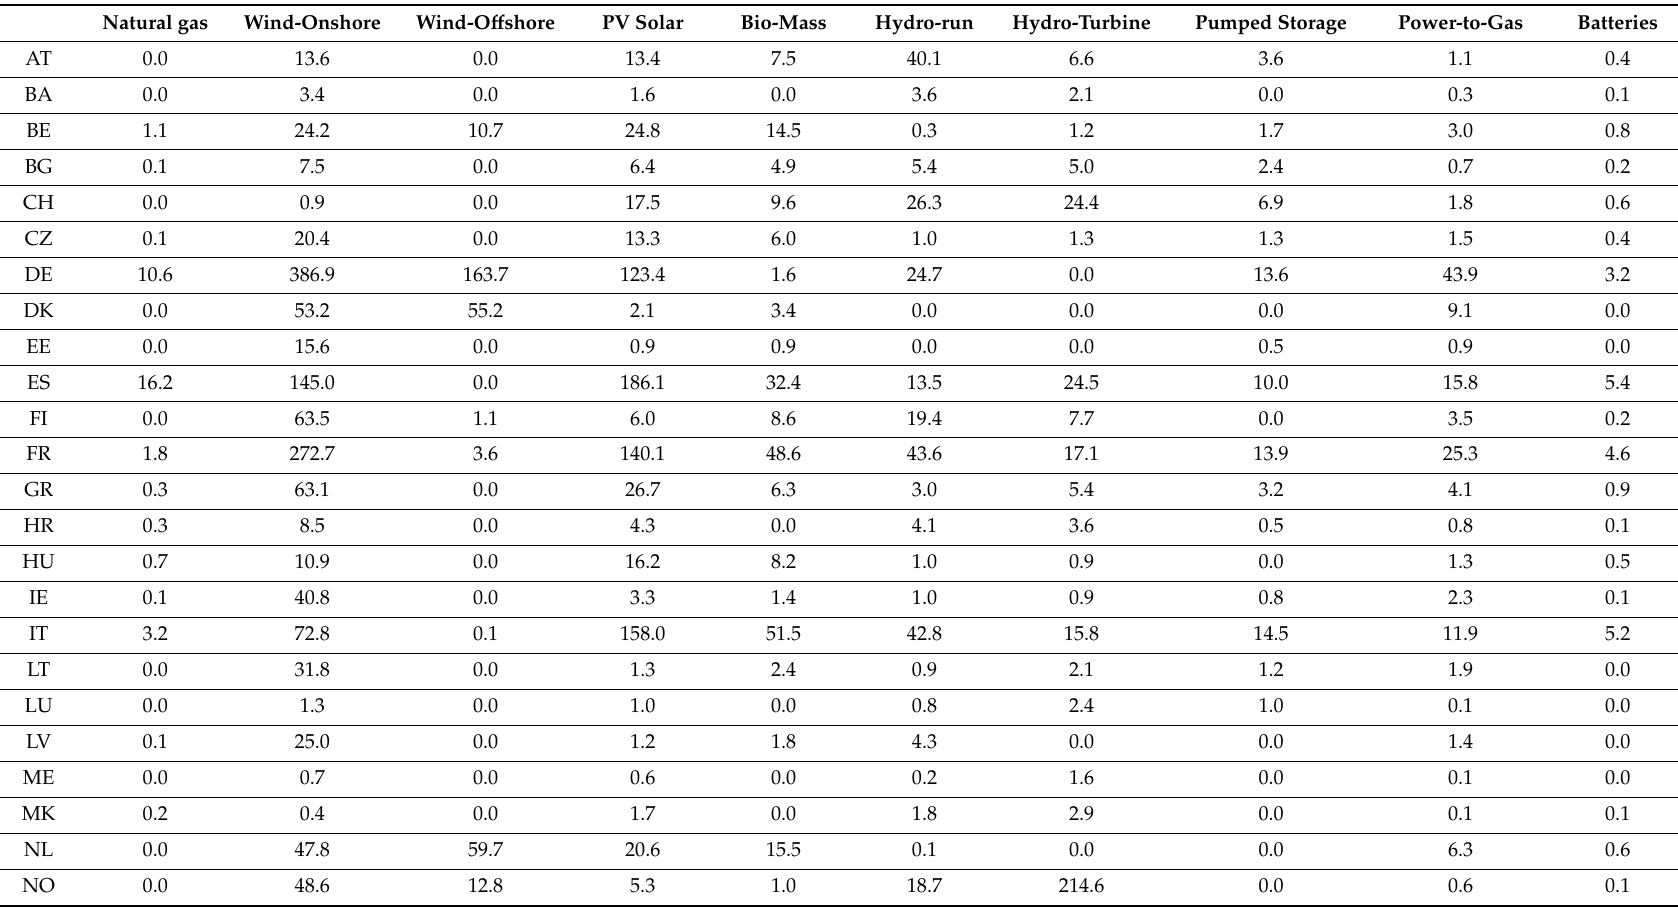
Table A5. Electricity generation in TWh, scenario year 2050 in the High Connectivity scenario. Source: own calculations. Natural gas Wind-Onshore Wind-O ff shore PV Solar Bio-Mass Hydro-run Hydro-Turbine Pumped Storage Power-to-Gas